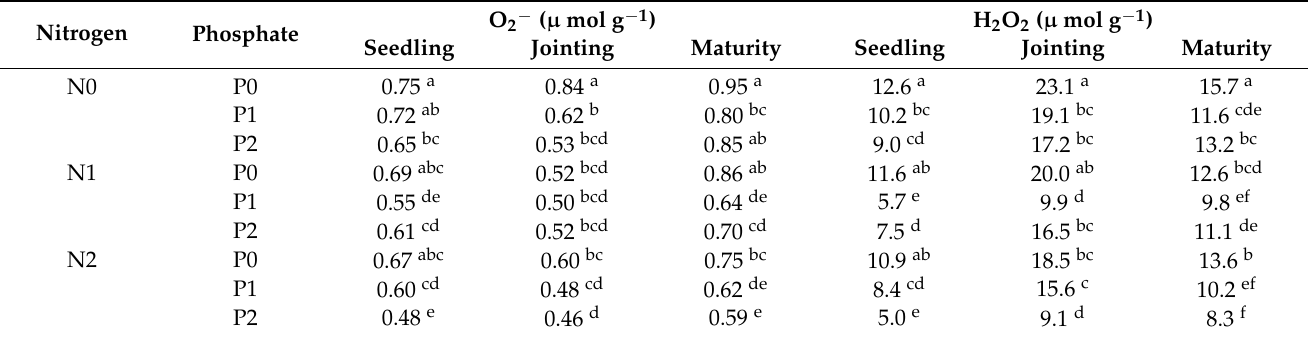
Table 4. Effects of nitrogen and phosphorus on superoxide anion (O 2 − ) and hydrogen peroxide (H 2 O 2 ) content of sorghum plants grown in saline soils at the three growing stages of seedling, jointing, and